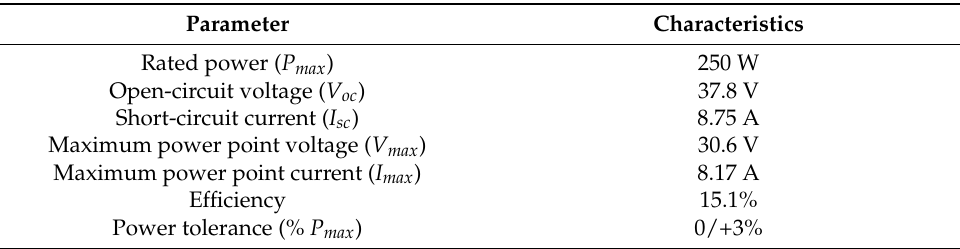
Table 5. Electrical characteristics of the monocrystalline Module ISF-250 [40]. Performance at STC: